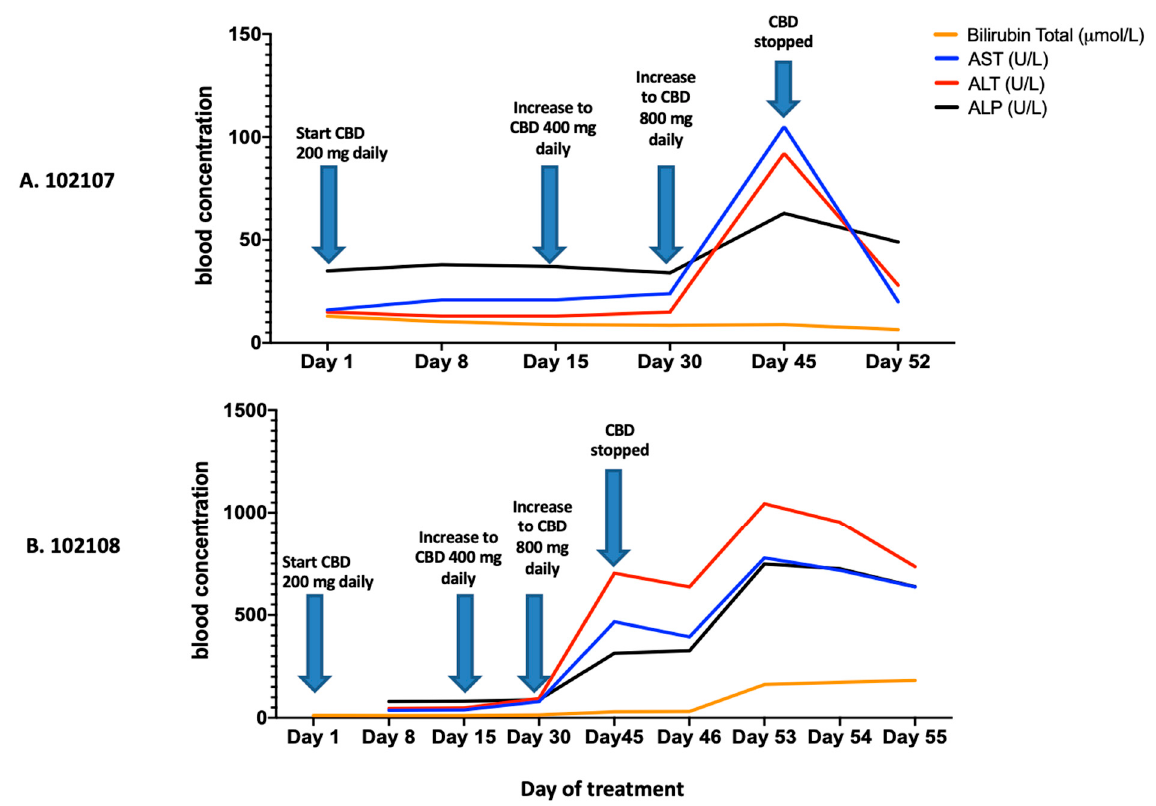
Figure 4. Dynamics of liver enzymes of participant #102107 and #102108 from arm 2 (TN-C200M2: CBD only), during cannabinoid uptake. Evolution of liver enzyme blood levels in ( A ). participant #102107 and ( B ). participant #102108 during the up-titration of CBD dose from the starting of CBD medication to the cessation of the treatment. Table 3. List of adverse events (AEs) experienced by the participants during the